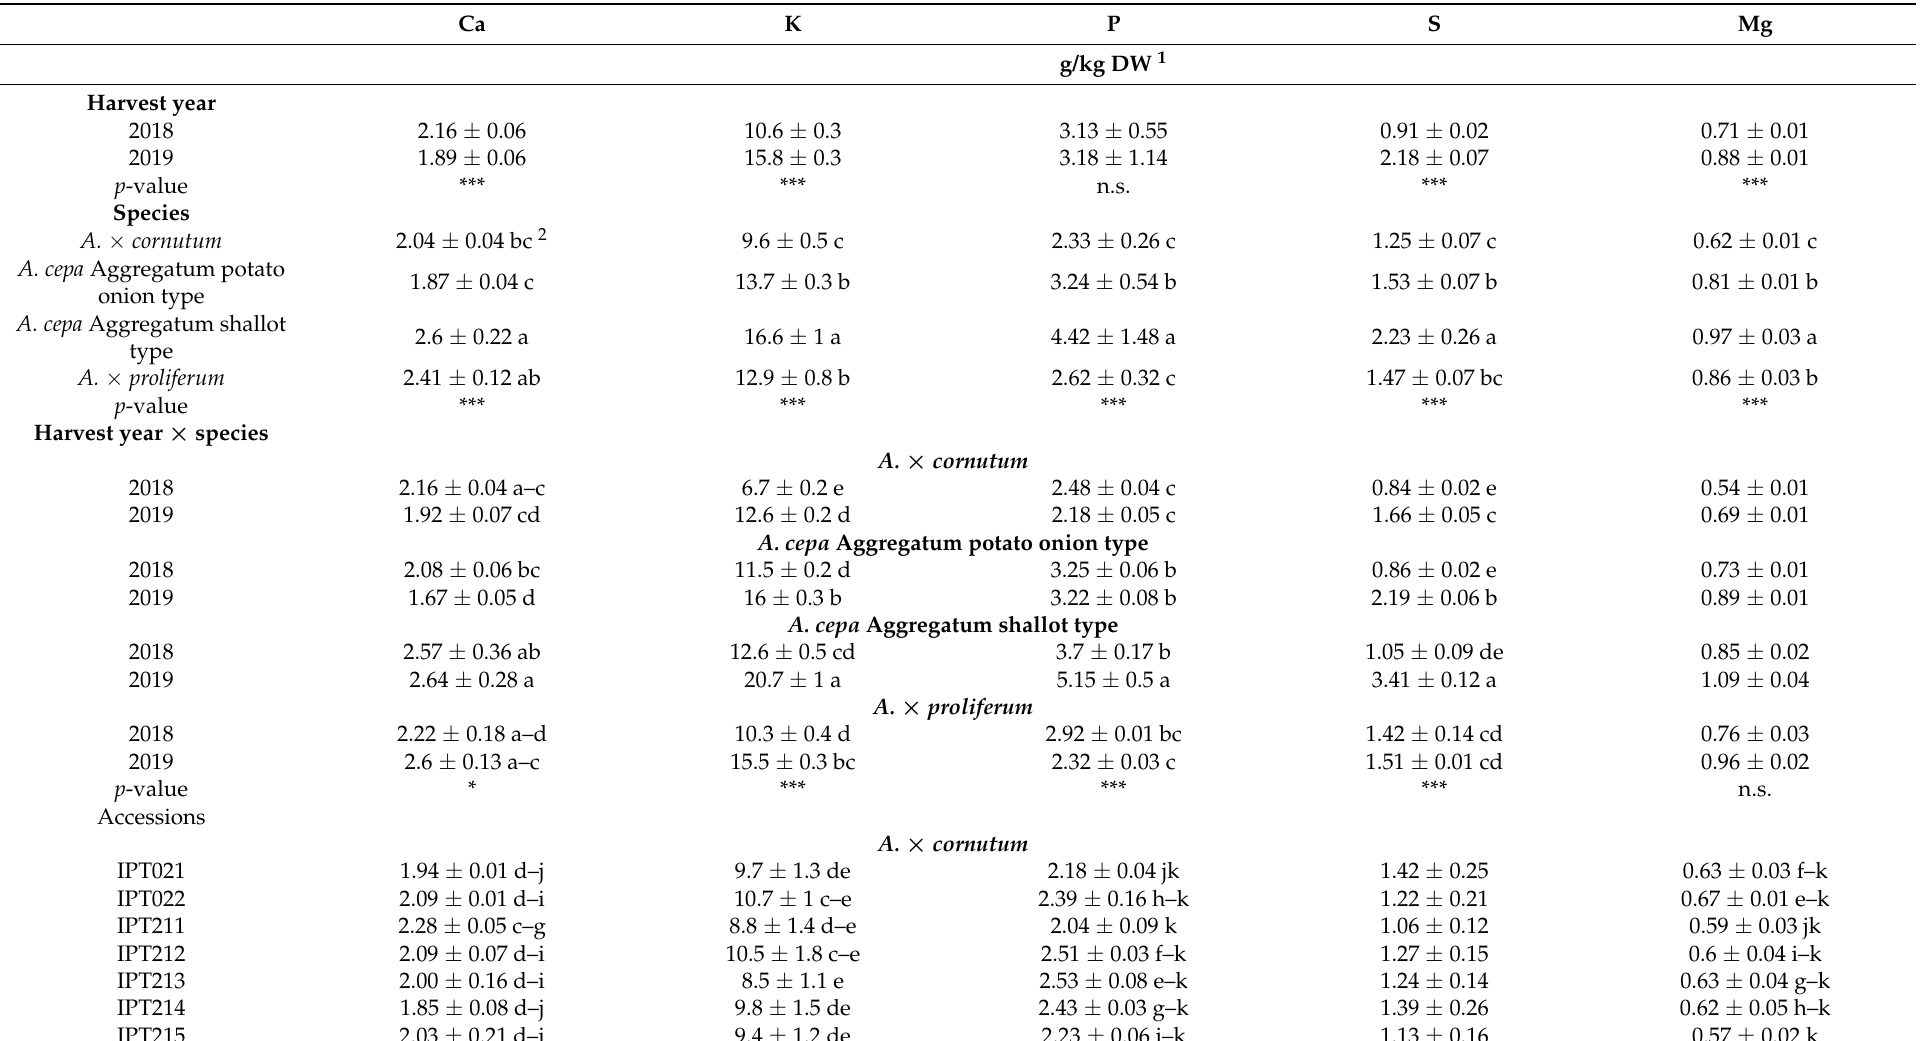
Table 3. Shallot macro-element composition by harvest year and species, their interaction and individual